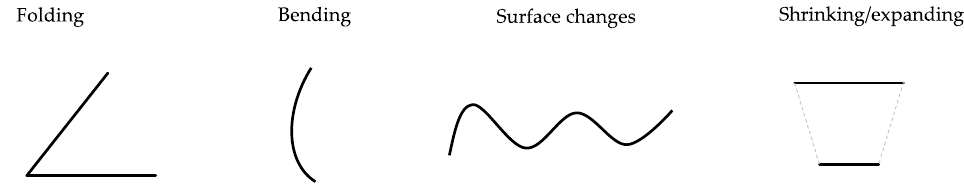
Figure 7. Design primitives for designing 4D textiles: folding, bending, surfaces changes and shrinking or expanding.